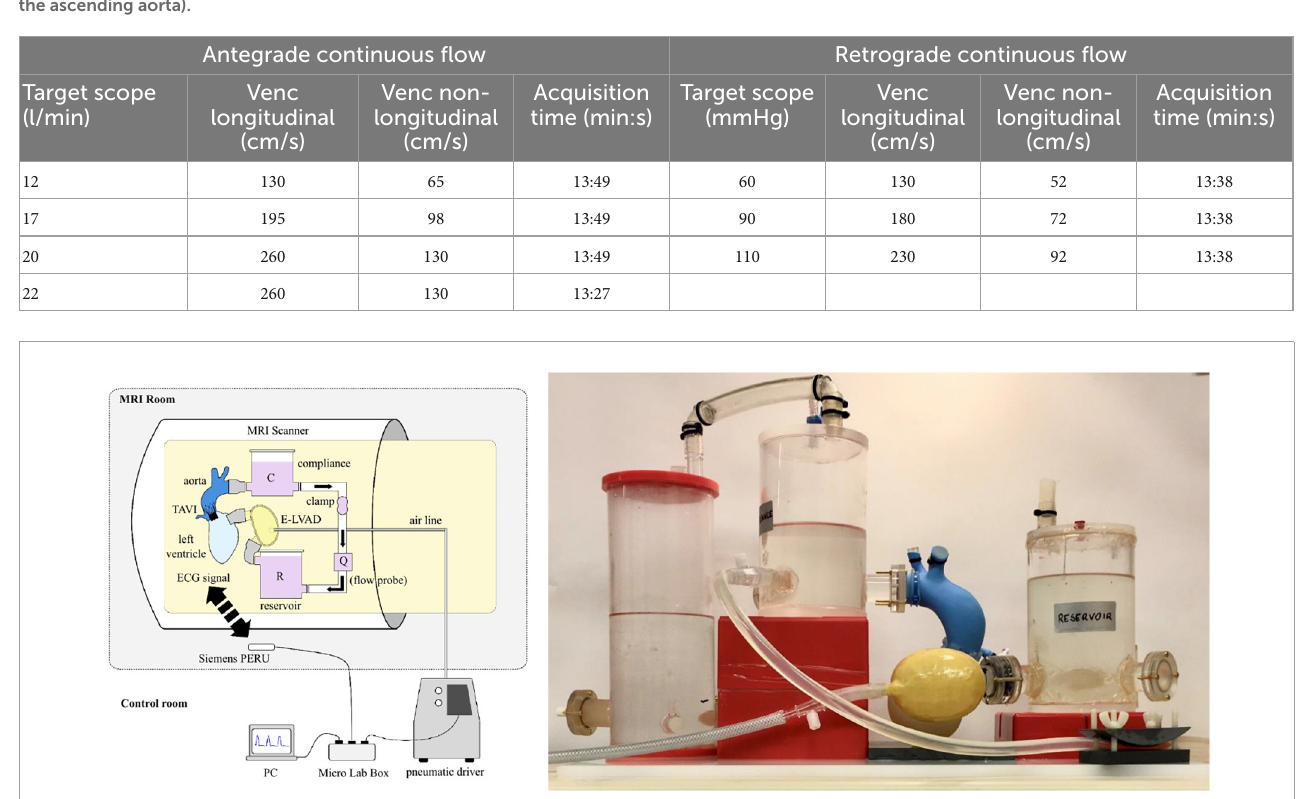
FIGURE3 Schematic representation of the pulsatile flow setup (left) and photograph of the mock loop (right) .